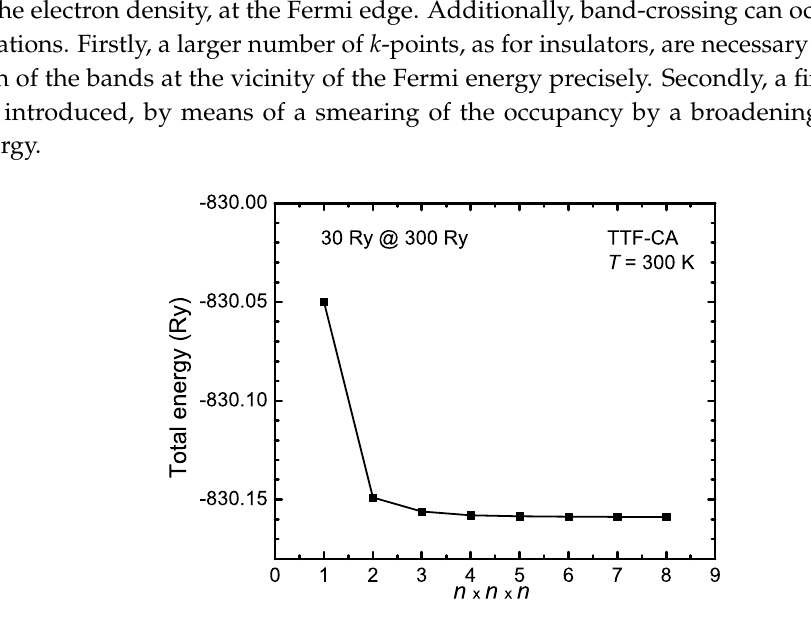
Figure B3. Illustration of the total energy of TTF-CA at 300 K as a function of k -grid size for E cut = 30Ry and E cut, ρ = 300 Ry. The total energy is converged above a grid size of 3 × 3 ×